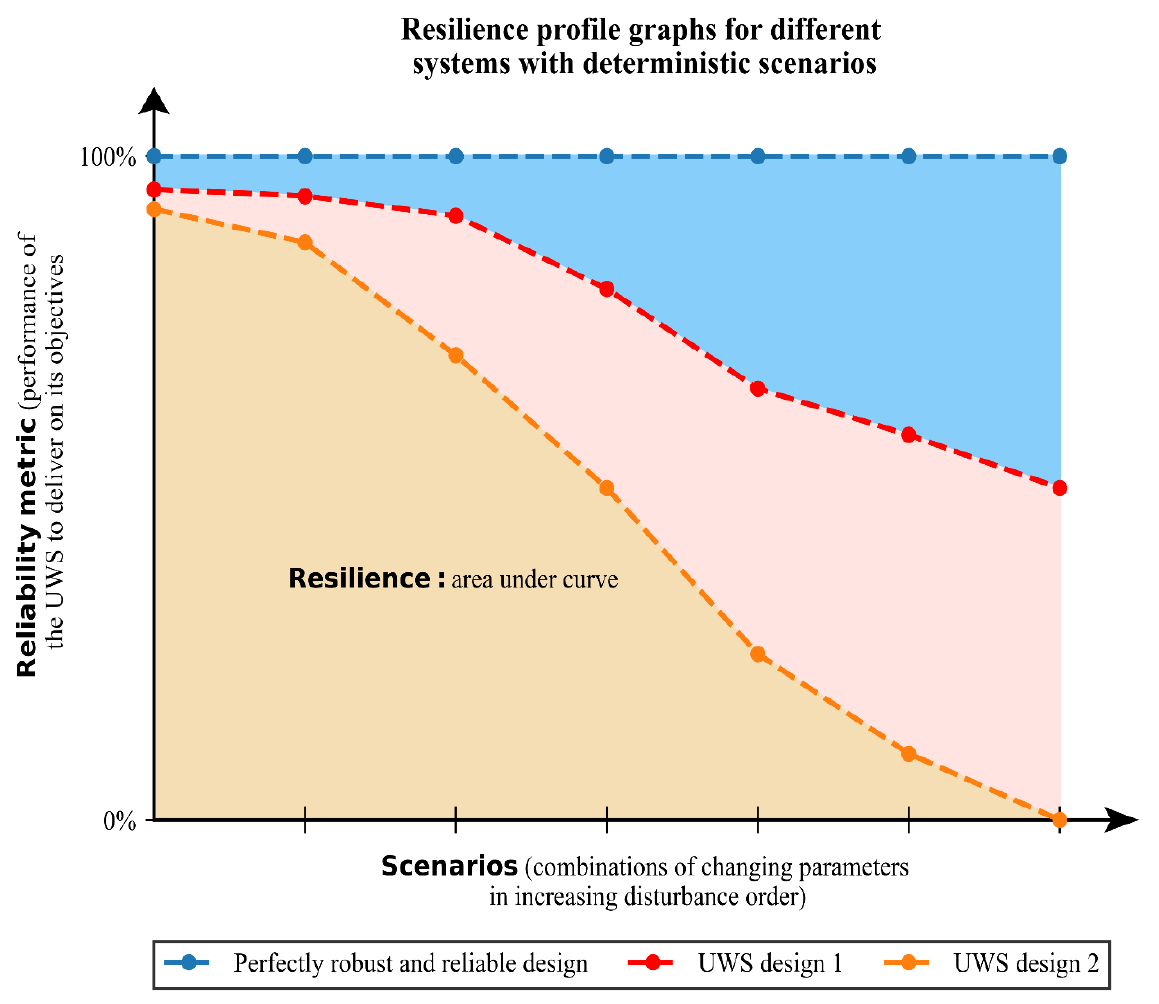
Figure 2. Resilience profile graphs for different UWS designs.